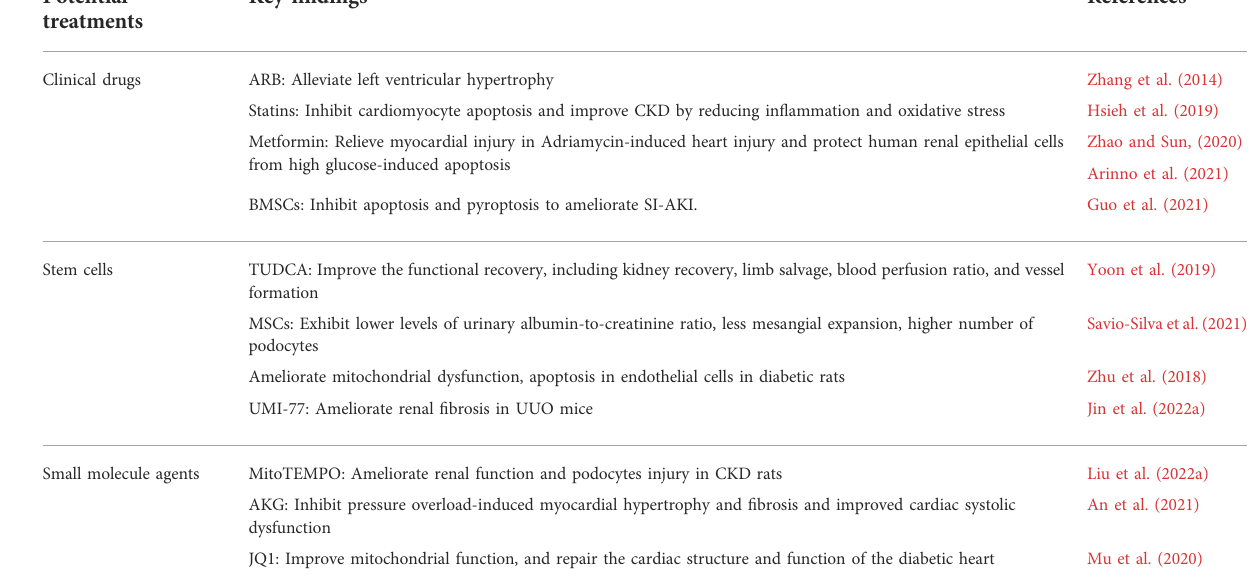
TABLE 1 Potential treatments targeting mitophagy in